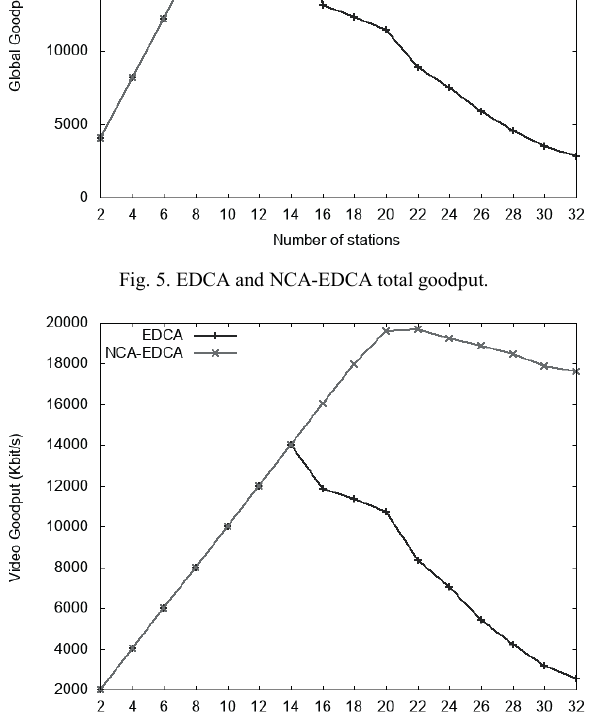
Fig. 6. EDCA and NCA-EDCA video goodput.